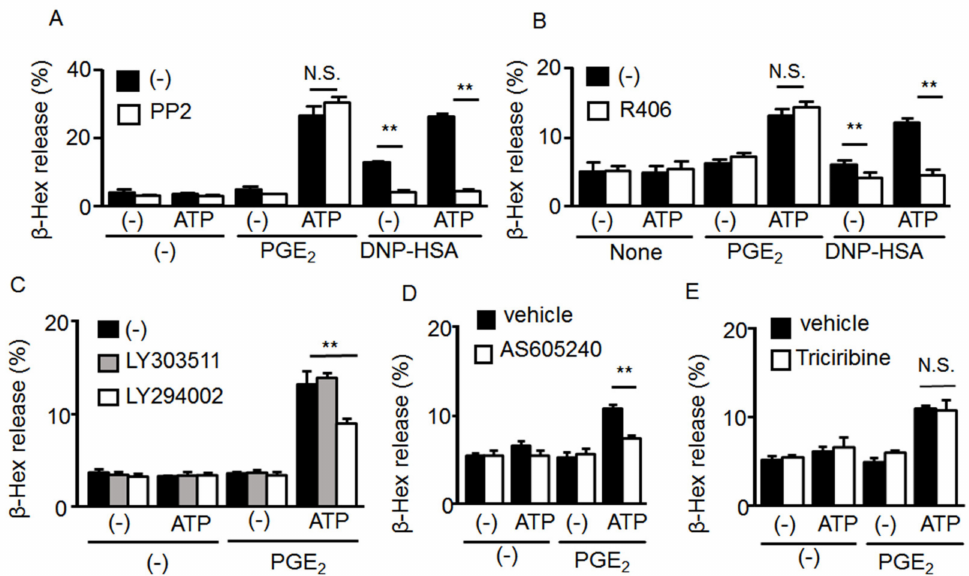
Figure 4. E ff ect of tyrosine kinase and phosphoinositide 3-kinase (PI3K) / Akt signaling pathway inhibitors on mast cell (MC) degranulation induced by co-stimulation with ATP and prostaglandin (PG)E 2 . ( A ) Bone marrow-derived MCs (BMMCs) were preincubated with a vehicle or the Src tyrosine kinase inhibitor PP2 (1 µ M) for 5 min and then stimulated with ATP (100 µ M) with or without PGE 2 (1 µ M) or 2,4-dinitrophenyl human serum albumin (DNP-HSA, 10 ng / mL). ( B ) BMMCs were preincubated with a vehicle or the Syk inhibitor R406 (2 µ M) for 5 min and then stimulated with ATP (100 µ M) with or without PGE 2 (1 µ M) ( n = 3). ( C ) BMMCs were preincubated with a vehicle, the PI3K inhibitor LY294002 (10 µ M), or the control compound LY303511 (10 µ M) for 5 min and then stimulated with ATP (0.1 mM) with or without PGE 2 (1 µ M) ( n = 3). ( D ) BMMCs were preincubated with a vehicle or the PI3K γ inhibitor AS605240 (1 µ M) for 5 min and then stimulated with ATP (100 µ M) with or without PGE 2 (1 µ M) ( n = 3). ( E ) BMMCs were preincubated with a vehicle or the Akt inhibitor triciribin (10 µ M) for 5 min, and then stimulated with ATP (100 µ M) with or without PGE 2 (1 µ M) ( n = 3). Data are shown as the mean ± SEM. N.S. no significant di ff erence, ** p < 0.01 indicates